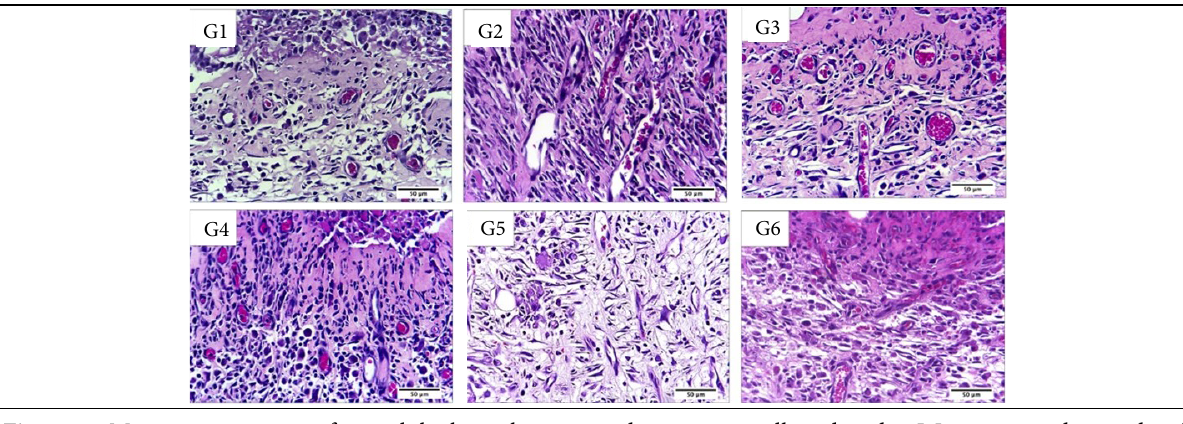
Figure 7 - Microscopic aspects of partial thickness burn wounds experimentally induced in Wistar rats and treated with silver-based dressings 14 DAI, scale bar = 50 μ m.